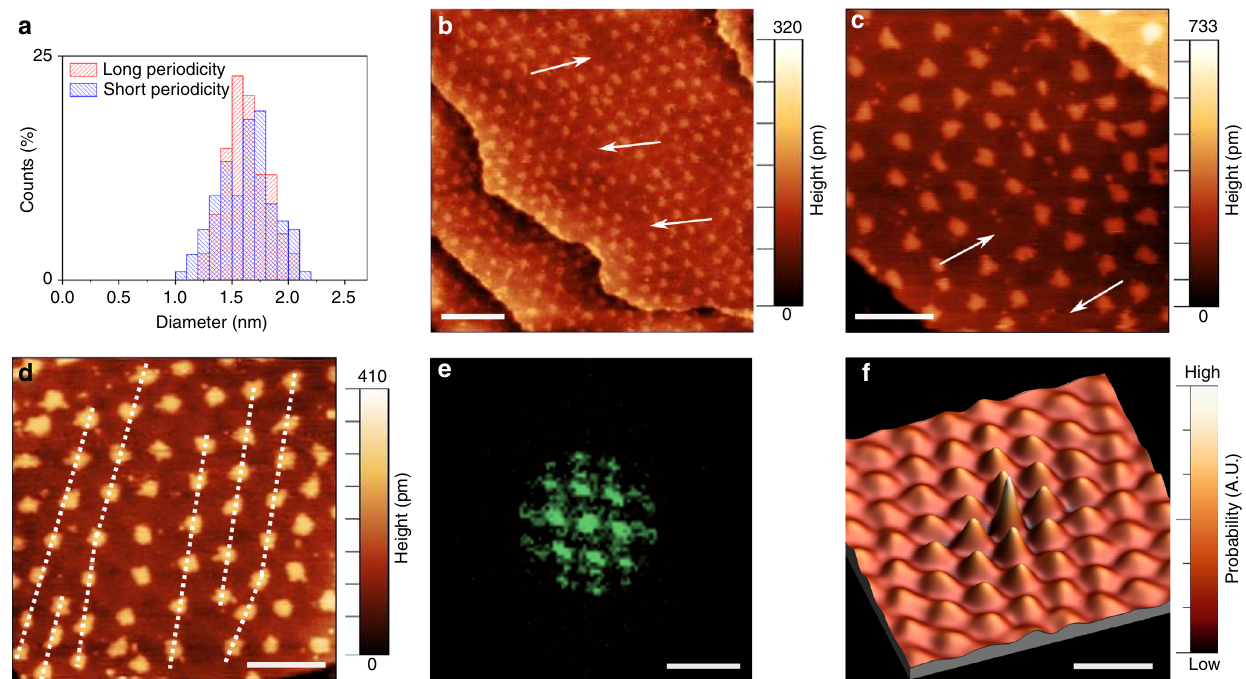
Fig. 3 Ordering of the graphene nanodot superlattice. a Histogram of the size of the dots. The average dot diameter is 1.60 ± 0.18 nm in the case of the sample with periodicity of 5.9 ± 0.9 nm (long periodicity, red histogram ), and is 1.63 ± 0.27 nm in the case of the sample with shorter periodicity (3.5 ± 0.7 nm, blue histogram ). b , c STM images reporting vacancy-like and d dislocation-like defects within the dot superlattice. e Fourier transform and f 2D autocorrelation image of the STM micrograph in c , highlighting the periodicity of the graphene nanodot superlattice. In f , peaks and valleys correspond to distances from a dot at which there is higher or lower probability of fi nding another dot. The scale bars are 20 nm in b , 10 nm in c , d , f and 0.4 nm − 1 in e . Imaging parameters: a 1.0 V and 0.9 nA; b , c − 1.2 V and 0.2 (Fig. 4d) con fi rms the presence of the inner six spots due to the long-range periodicity of the graphene dots — in this sample the periodicity in real space is 3.4 nm. Three of the six diffraction points are obscured by the threefold outer lines arising from the periodicity of the moiré of the graphene areas.